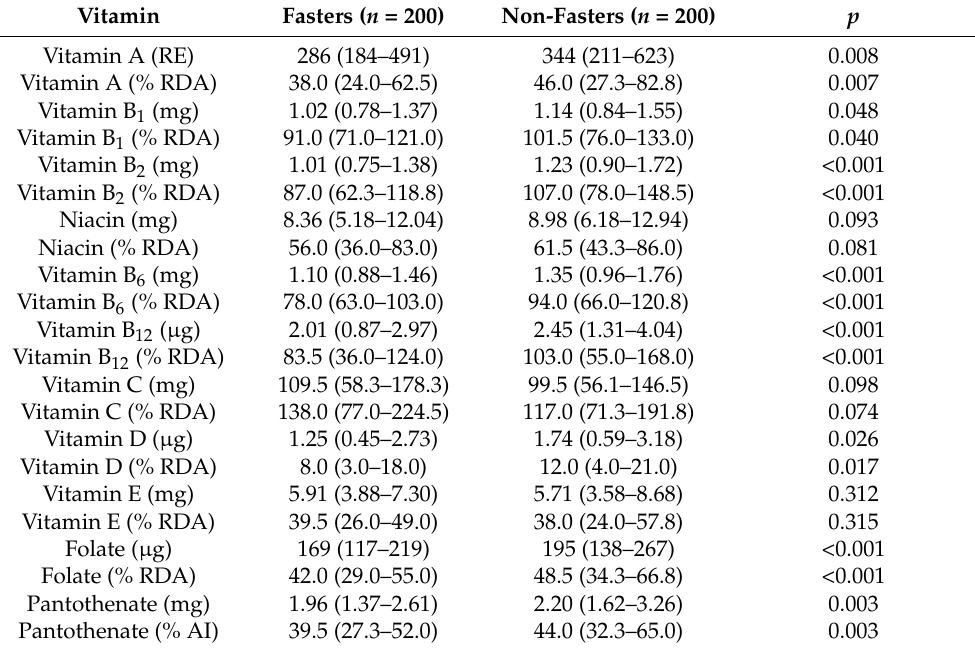
Table 2. Daily vitamin intakes by the two groups, based on three-day dietary records (median and interquartile range).